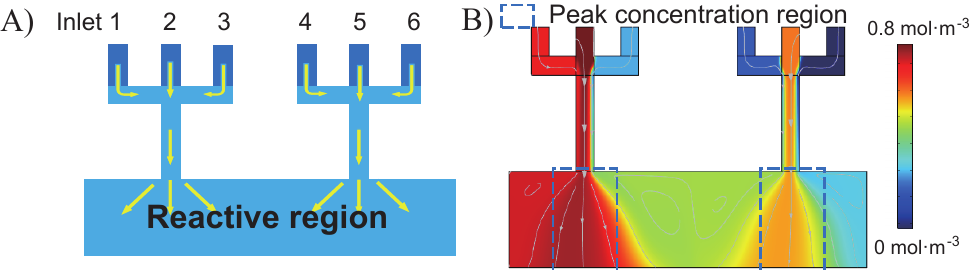
Figure 1. ( A ) The schematic of the proposed gradient generator, which has six inlets and one reactive region. ( B ) One demonstrated example with randomly generated inlet configurations, which has two peak concentration regions and three valley concentration regions.